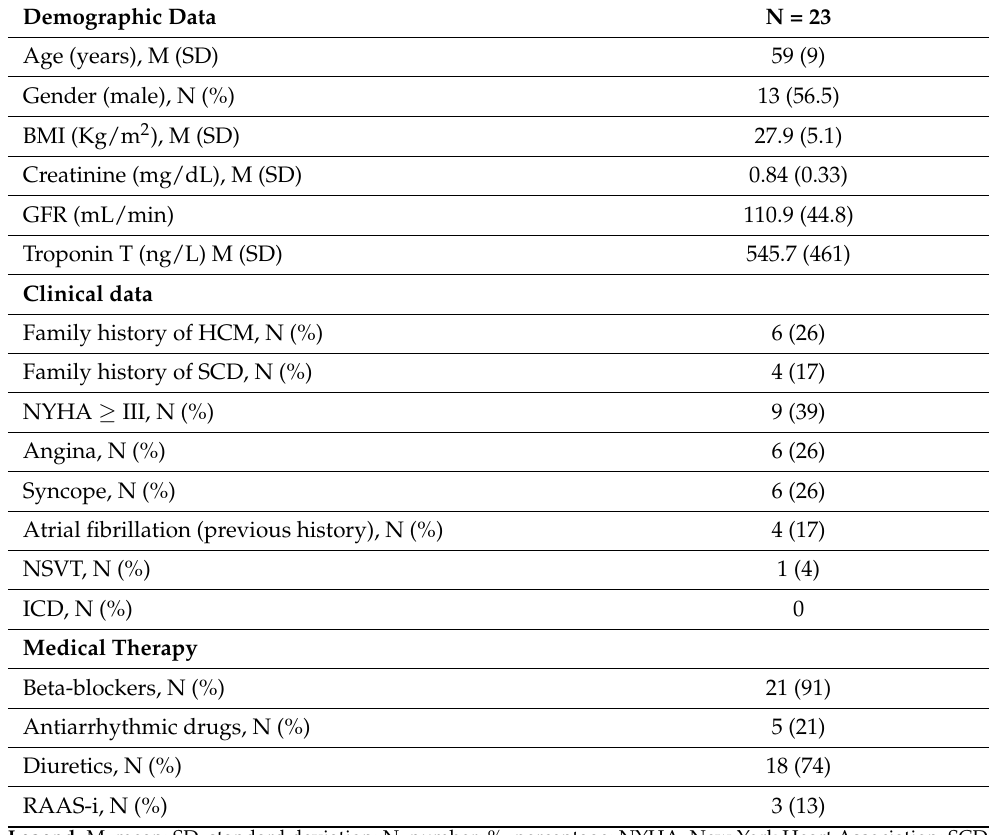
Table 1. Baseline characteristics of HCM